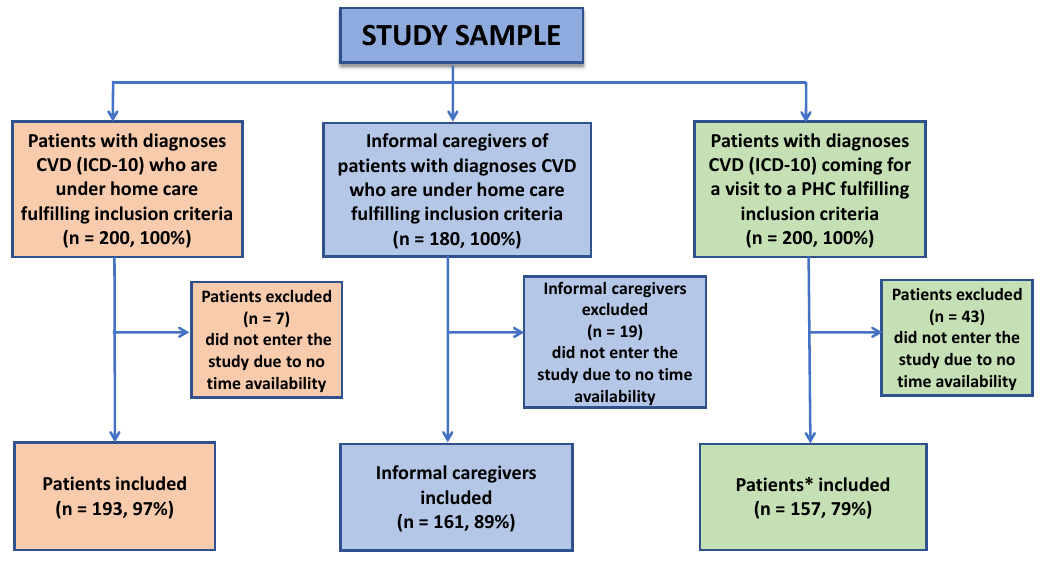
Figure 1. Flow diagram for the sample of CVD patients and their